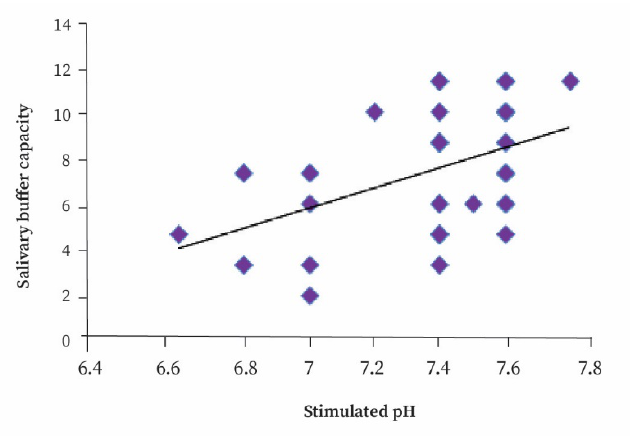
Figure 9. Correlation between salivary buffer capacity and stimulated pH.